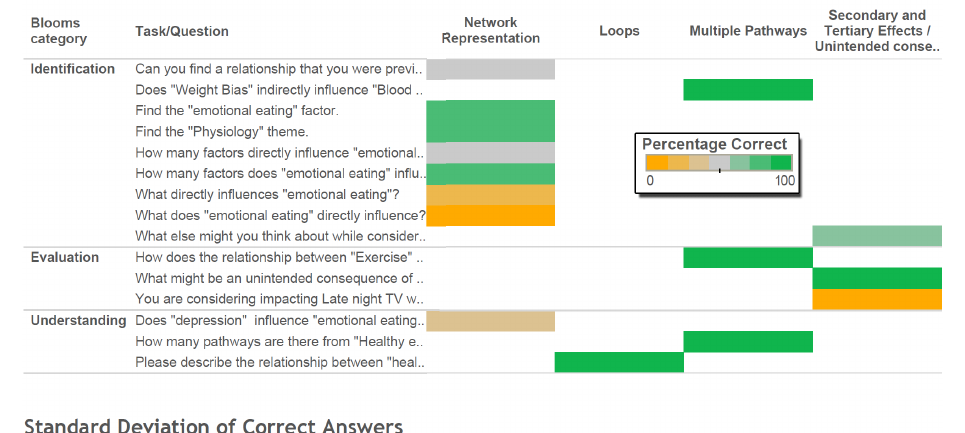
Figure 8. Time to complete each task for each user. Darker colors indicate a longer time to comple-